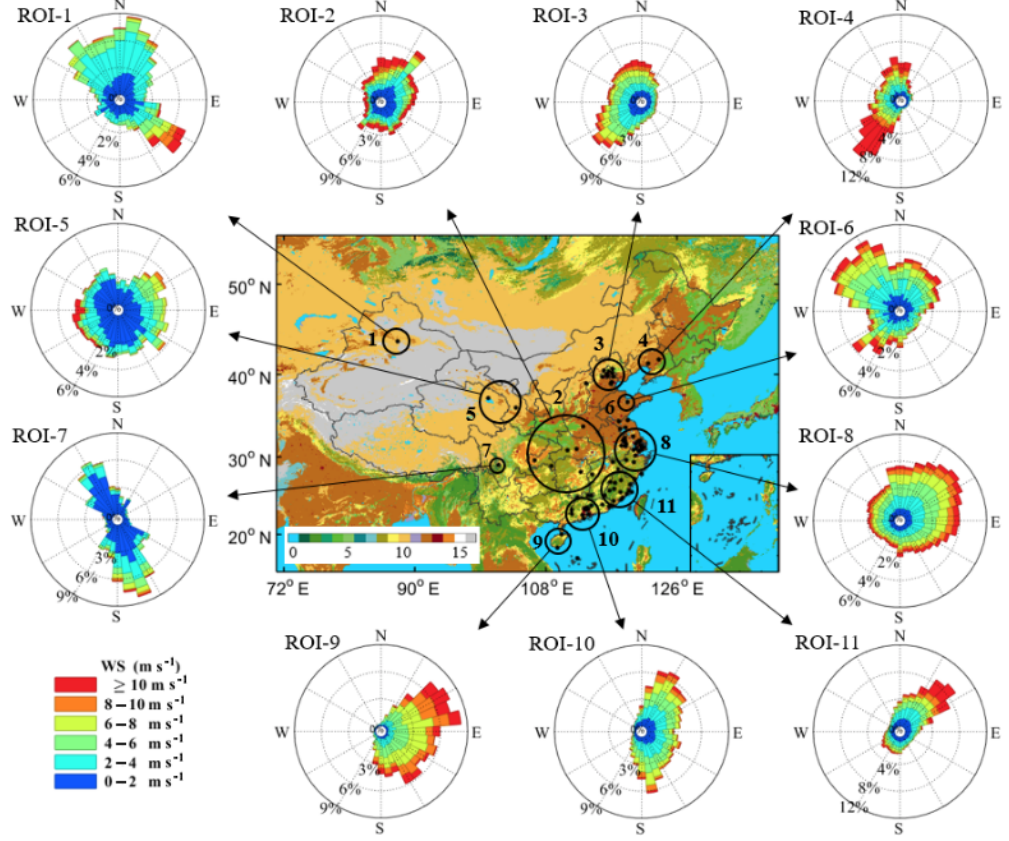
Figure 10. Spatial distribution of the statistical results of atmospheric wind fields at 500m above ground level (a.g.l.) for 11 regions of interest (ROIs). The wind rose plots over the 11 ROIs are calculated from hourly observations of wind direction and wind speed from November 2018 to March 2019. The land cover types 0–16 represent water, evergreen needleleaf forest, evergreen broadleaf forest, deciduous needleleaf forest, deciduous broadleaf forest, mixed forest, closed shrublands, open shrublands, woody savannas, savannas, grasslands, permanent croplands, urban and built-up areas, cropland/natural vegetation mosaic, snow and ice, and barren or sparsely vegetated areas,